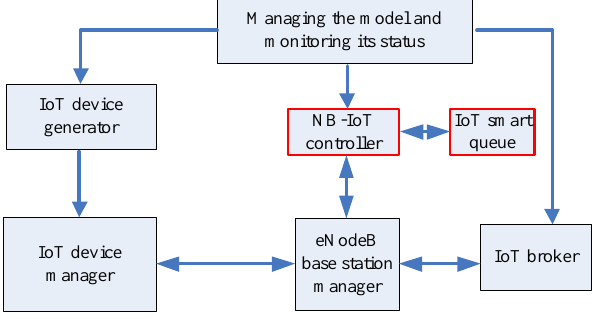
Figure 9. The simulation model for the LTE/IoT integrated solution.